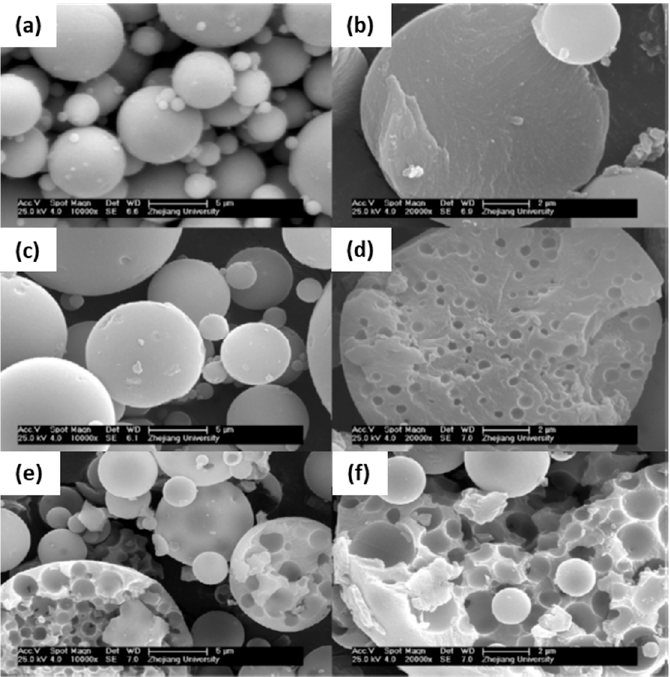
Figure 20. SEM photomicrographs of TiO 2 microspheres exhibiting inner incontinuous macroporos- ity, prepared by O/W emulsion method combined with sol-gel transition and phase separation. The larger the amount of phase separation inducer (PVP), the larger the pore volume and size. ( a , b ) 0 g PVP; ( c , d ) 0.190 g PVP; ( e , f ) 1.903 g PVP. Reprinted from Chinese Chem. Lett., Vol. 25, W. W. Cai,